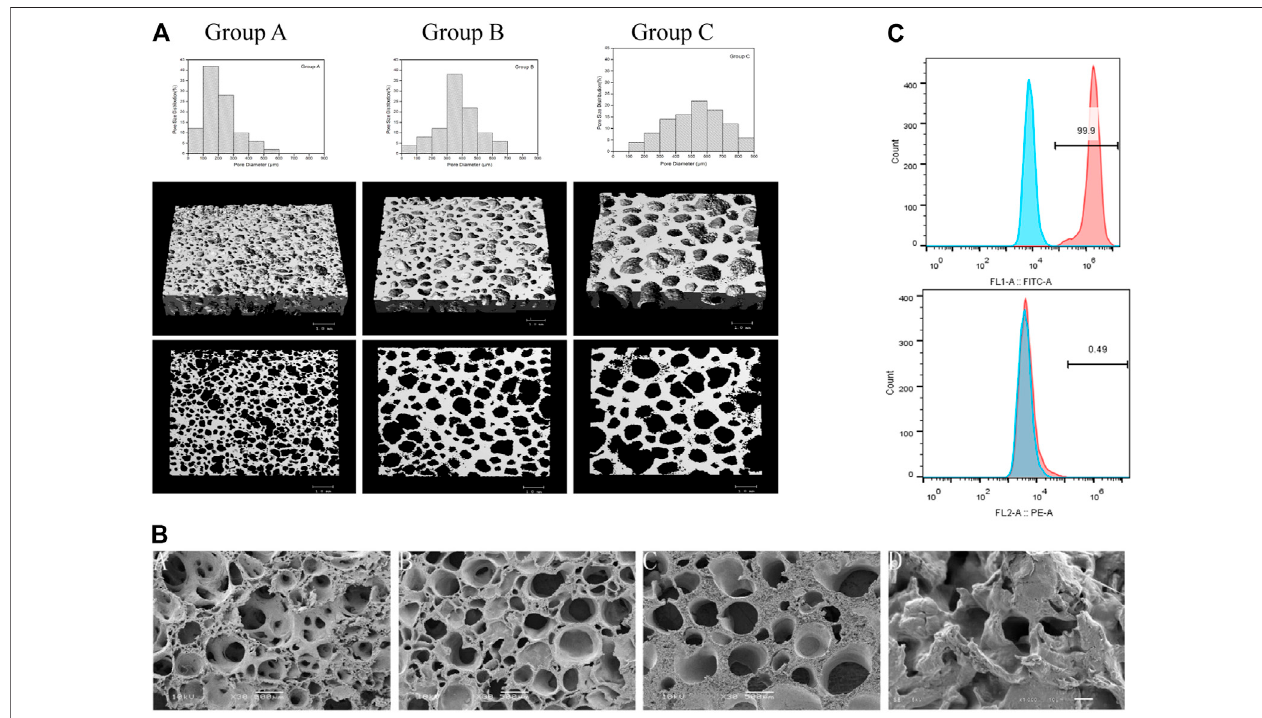
FIGURE 2 | Characterization of n-HA/PA66 composite scaffold. (A) 3D reconstructions of the micro-CT slices illustrating the distinct porosity, pore size, and distribution of the three groups of scaffolds, and the scale bars represent 1 mm. (B) SEM pictures of group A, group B, and group C, each at × 500 magni fi cation, showing the microporosity of the scaffolds and shows the surface in the × 1000 magni fi cation of the three group scaffolds, whereas no differences were noted. (C) Flow cytometry of BMSCs, including CD29 and CD31.